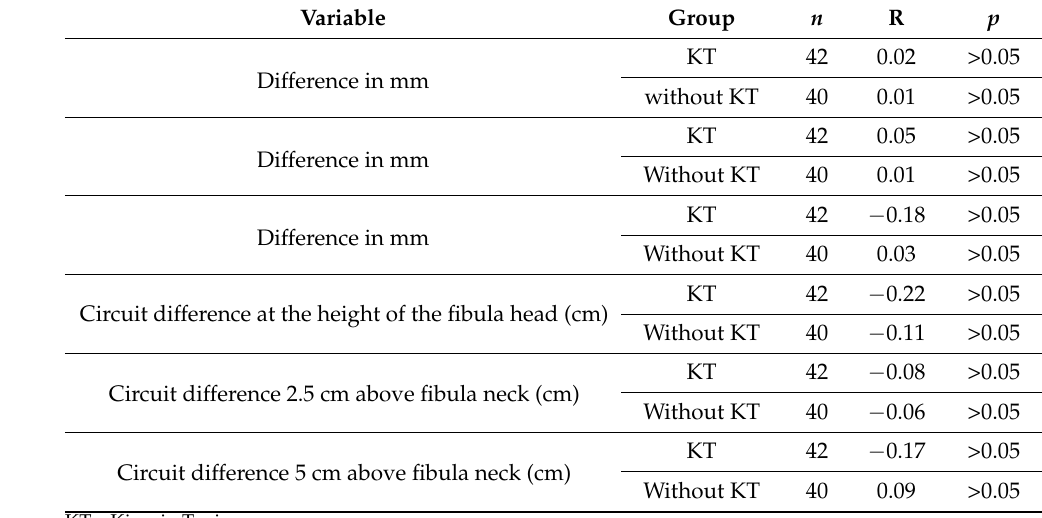
Table 7. The results of the correlation analysis of the change in improvement in the range of mo- tion (ROM) in the joint with the variables characterizing the level of subcutaneous tissue swelling according to the Spearman and Pearson